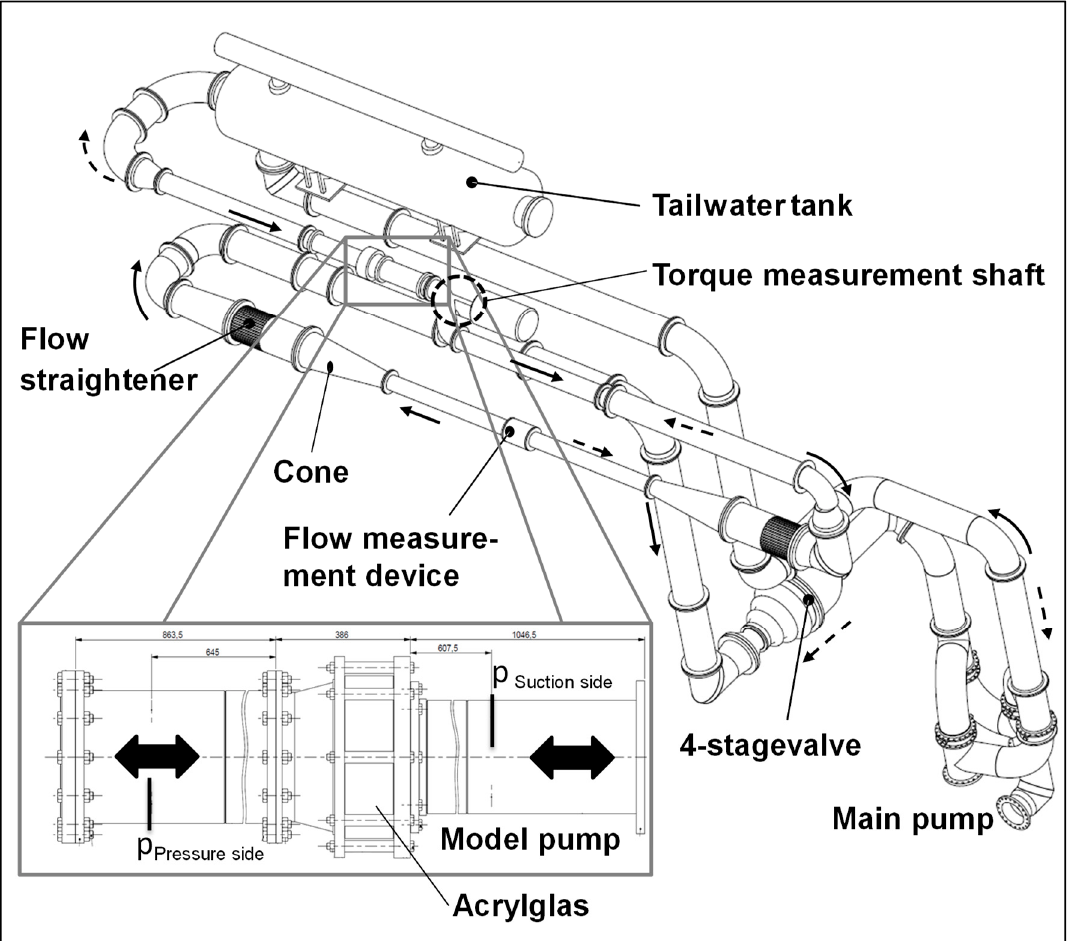
Figure 7. Four-quadrant test rig with model pump installed.